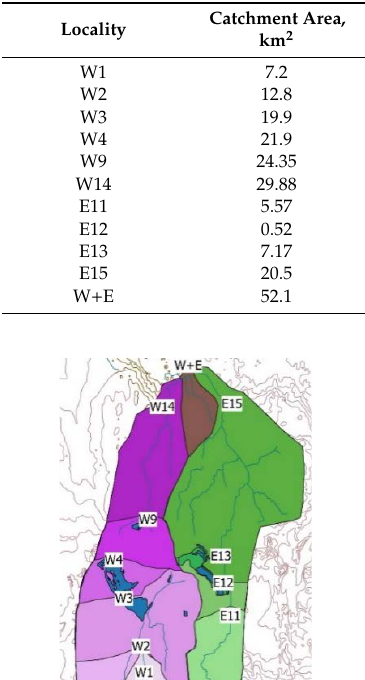
Table 5. Catchment areas.